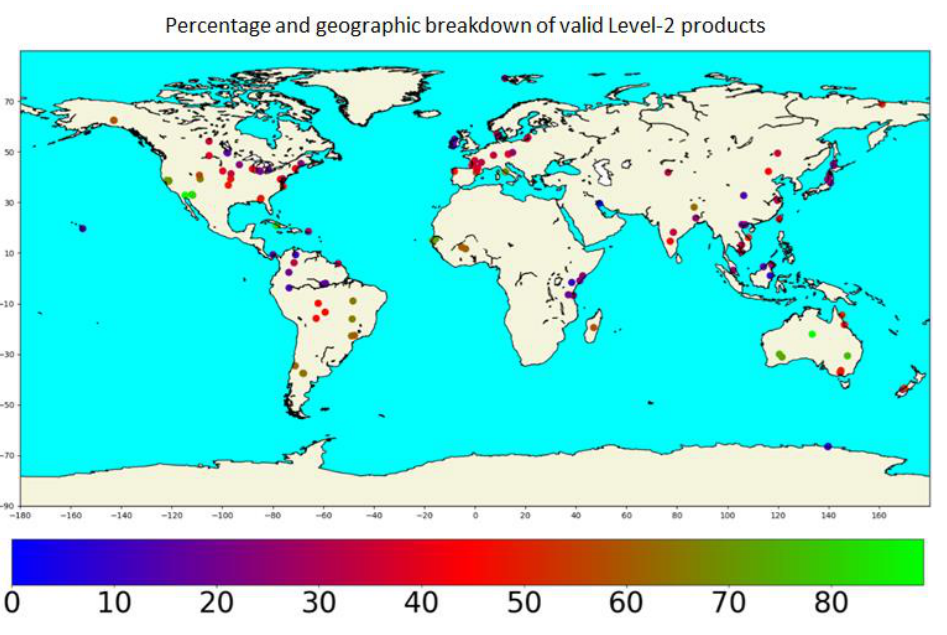
Figure 55. Percentage and geographic breakdown of valid Level-2 products.